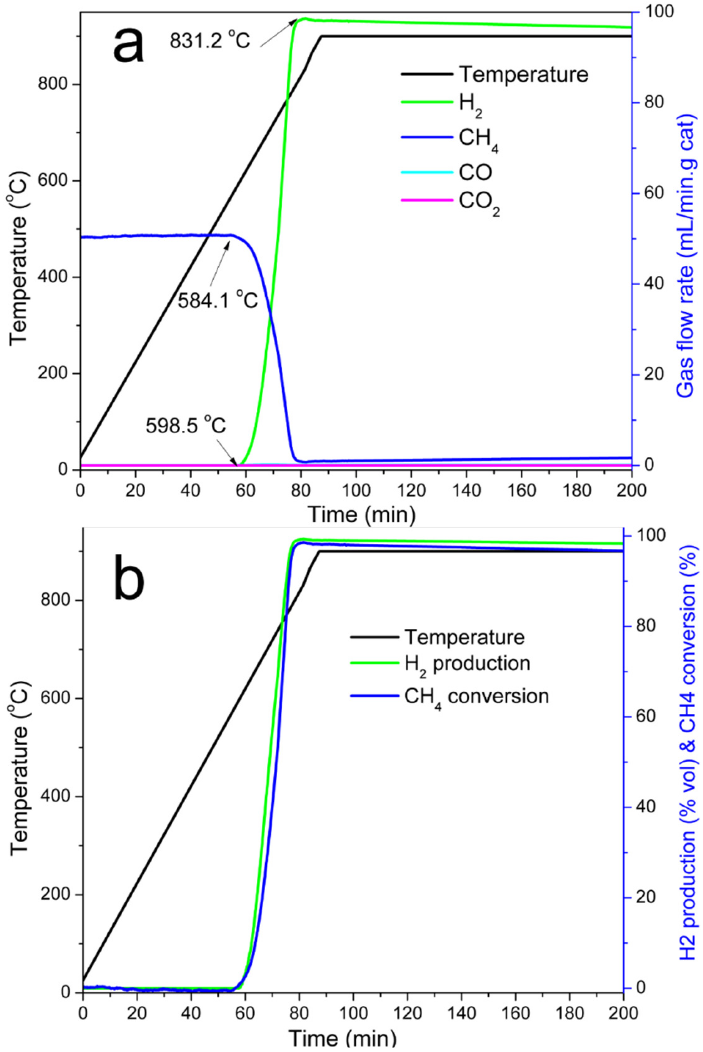
Figure 4. TPCDM over 25.5% Ni@G. ( a ). Gas flow rates vs. time, ( b ). H 2 vol% and CH 4 conversion rate (%) vs. time. Experimental conditions: 10 g catalyst, heating rate 10 °C/min, temperature range 25–900 °C, and flow rate of CH 4 100 mL/min.